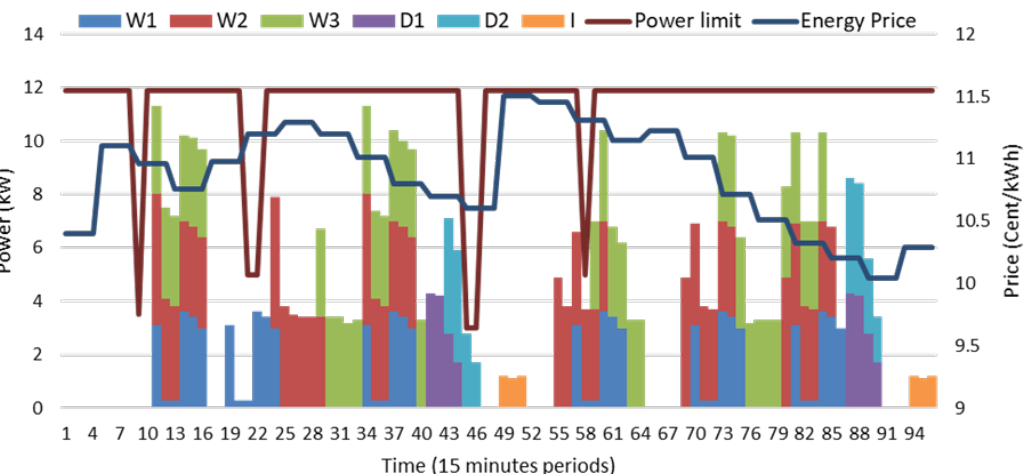
Figure 9. Power consumption of devices in scenario E (based on dynamic tariff and power consumption limit).